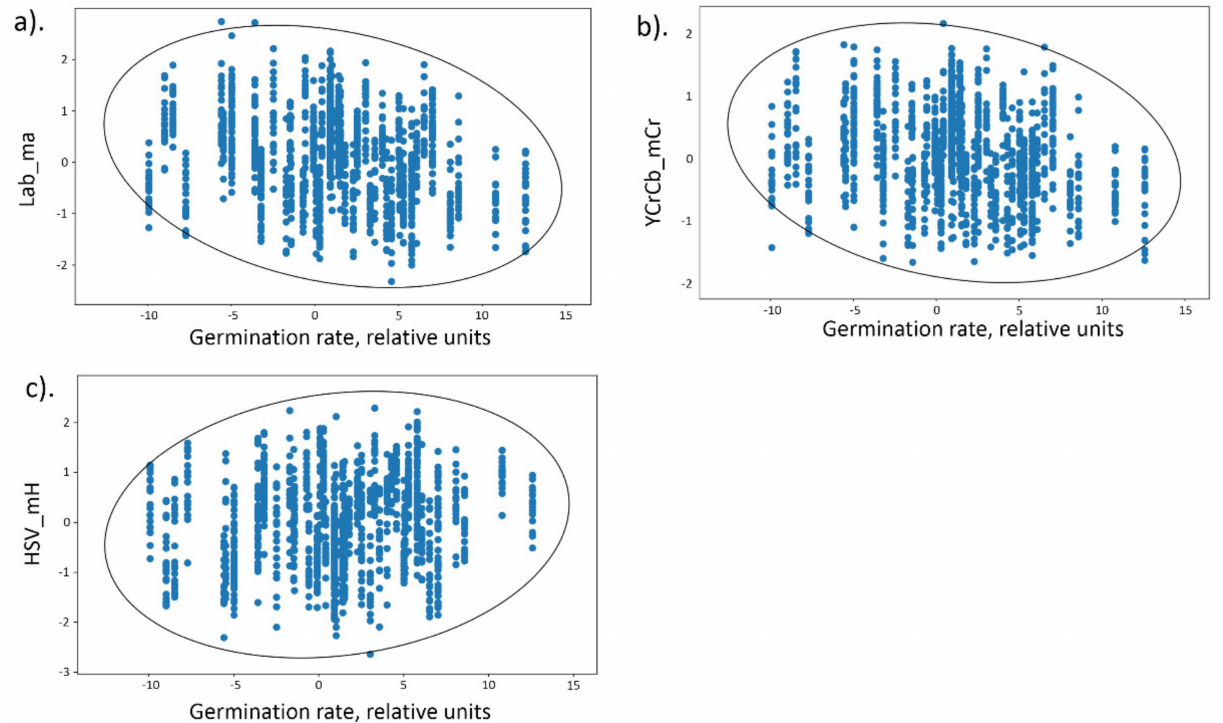
Figure 5. Scatter diagrams for germination values ( X axis) and grain color traits ( Y axis) of the RIL seeds (dots correspond to seeds): ( a ) Lab_ma, ( b ) YCrCb_mCr, ( c ) HSV_mH. Ellipsoids are shown at the 95% significance